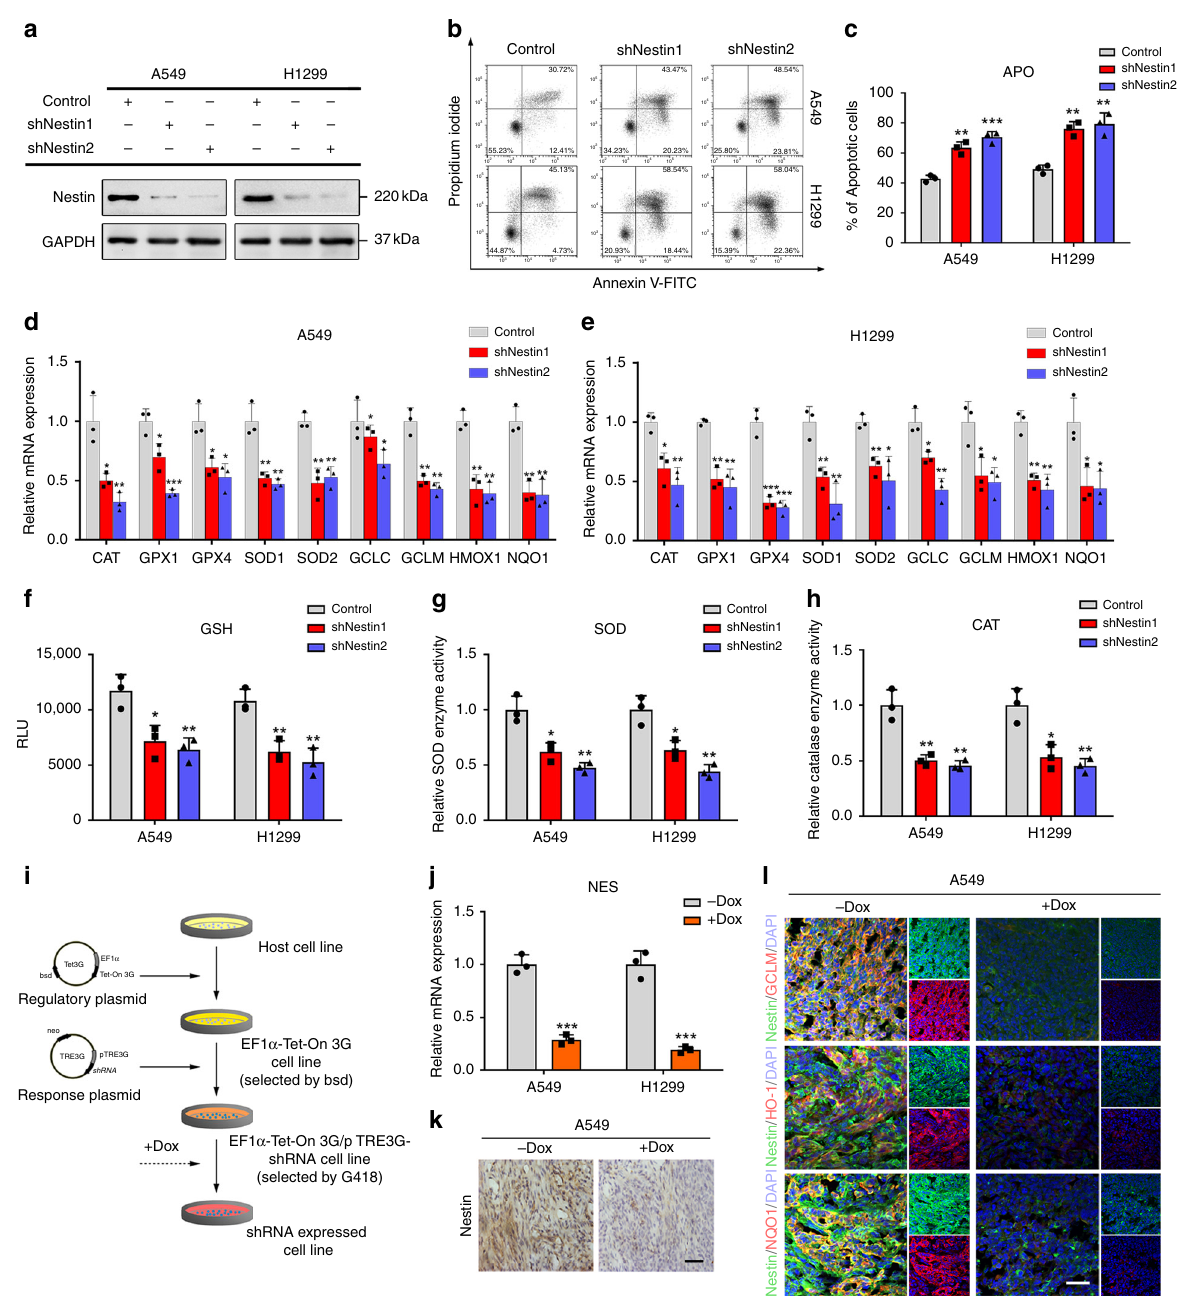
Fig. 1 Nestin knockdown reduces the antioxidant capacity in NSCLC cells. a Nestin was downregulated using speci fi c shRNAs (shNestin1 and shNestin2). At 72 h post-transfection, whole-cell extracts were prepared and Nestin levels were analyzed by Western blotting. b Flow cytometric detection of H 2 O 2 - induced NSCLC cell death was achieved using Annexin V-FITC and propidium iodide (PI). c Statistical analysis of the total apoptosis rate in NSCLC cells. d , e qPCR analysis showing that knockdown of Nestin reduced the expression levels of several antioxidation-related genes compared to those seen in control cells. f Analysis of GSH levels in NSCLC cells. g SOD activity in NSCLC cells was examined with a SOD assay kit. h Analysis of CAT levels in NSCLC cells. i The Tet-On 3G doxycycline-inducible gene expression system was used to control the translation of a human Nestin-targeting shRNA driven by the TRE3G promoter (PTRE3G) in NSCLC cells. Brie fl y, NSCLC cells were transfected with the EF1 α -Tet-On 3G-bsd plasmid and selected with blasticidin. The cells were then transfected with the pTRE3G-shRNA-neo plasmid, in which the shRNA was incorporated downstream of Tet-regulated PTRE3G. The cells were selected with neomycin, and shRNA expression was induced in surviving cells with doxycycline (Dox) treatment. j The ability of the Tet-On 3G doxycycline-inducible gene expression system to downregulate Nestin in NSCLC cells in vitro was con fi rmed by qPCR. k IHC staining indicating that Nestin expression was downregulated in xenograft tumors following doxycycline treatment in vivo. Brie fl y, A549 cells transfected with EF1 α -Tet-On 3G-bsd and pTRE3G-shRNA-neo plasmids were subcutaneously injected into nude mice. Two weeks later, mice were fed diets with or without Dox (625 mg/kg food). Xenograft tumors were collected 5 weeks after grafting, and IHC staining was performed. Scale bar: 50 μ m. l Representative images of immuno fl uorescence. Xenograft tumor samples were obtained as described in k and labeled with anti-GCLM/HO-1/NQO1 (red), anti-Nestin (green) and 4 ′ ,6-diamidino-2-phenylindole (DAPI; blue). Scale bar: 50 μ m. Data are presented as the means± SD of three independent experiments. * P < 0.05, ** P < 0.01 and *** P < 0.001, Student ’ s t- test. Source data are available as a Source Data fi le NATURE COMMUNICATIONS| (2019) 10:5043